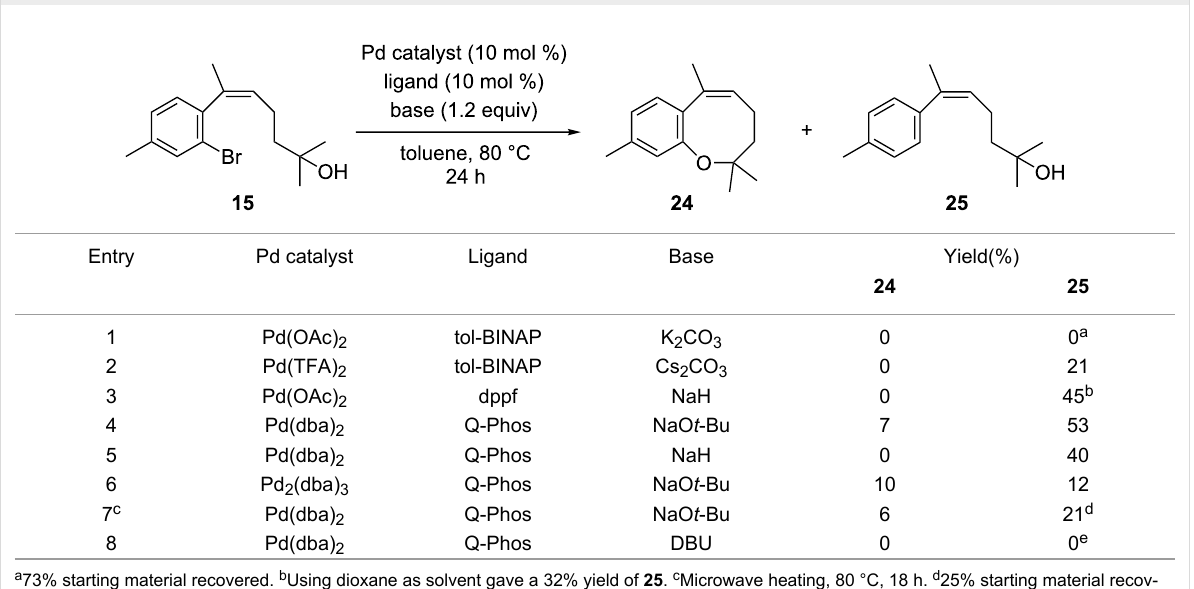
Table 2: Buchwald–Hartwig etherifications of bromoalcohol 15